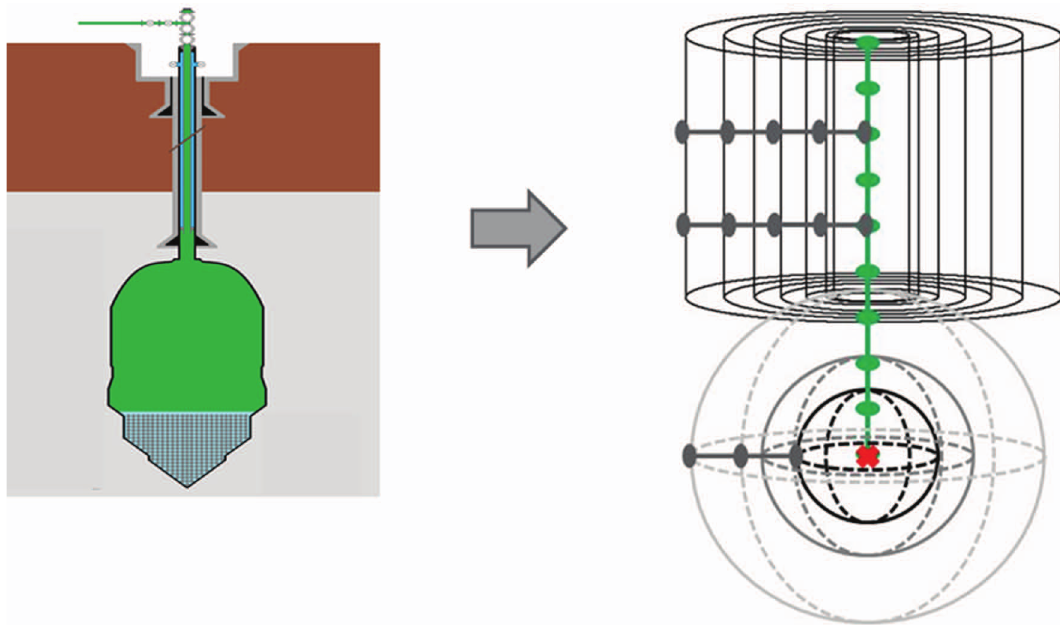
Fig. 1. Simpli fi ed model